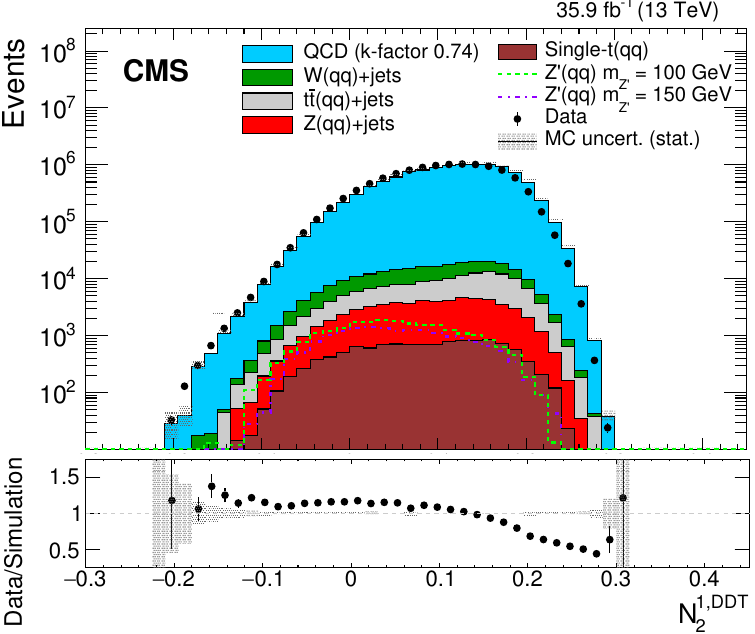
Figure 3 . Distributions of data (points) and simulated backgrounds (histograms), of the N 1 ; DDT variable for the leading p T jet after the kinematic selection. Dashed lines illustrate the signal contribution for di(cid:11)erent Z 0 boson masses. The multijet processes (QCD) dominate the background component, with subdominant contributions from inclusive SM W, Z, and tt and single top quark processes. The QCD simulation is corrected by an overall factor of 0.74 to match the data